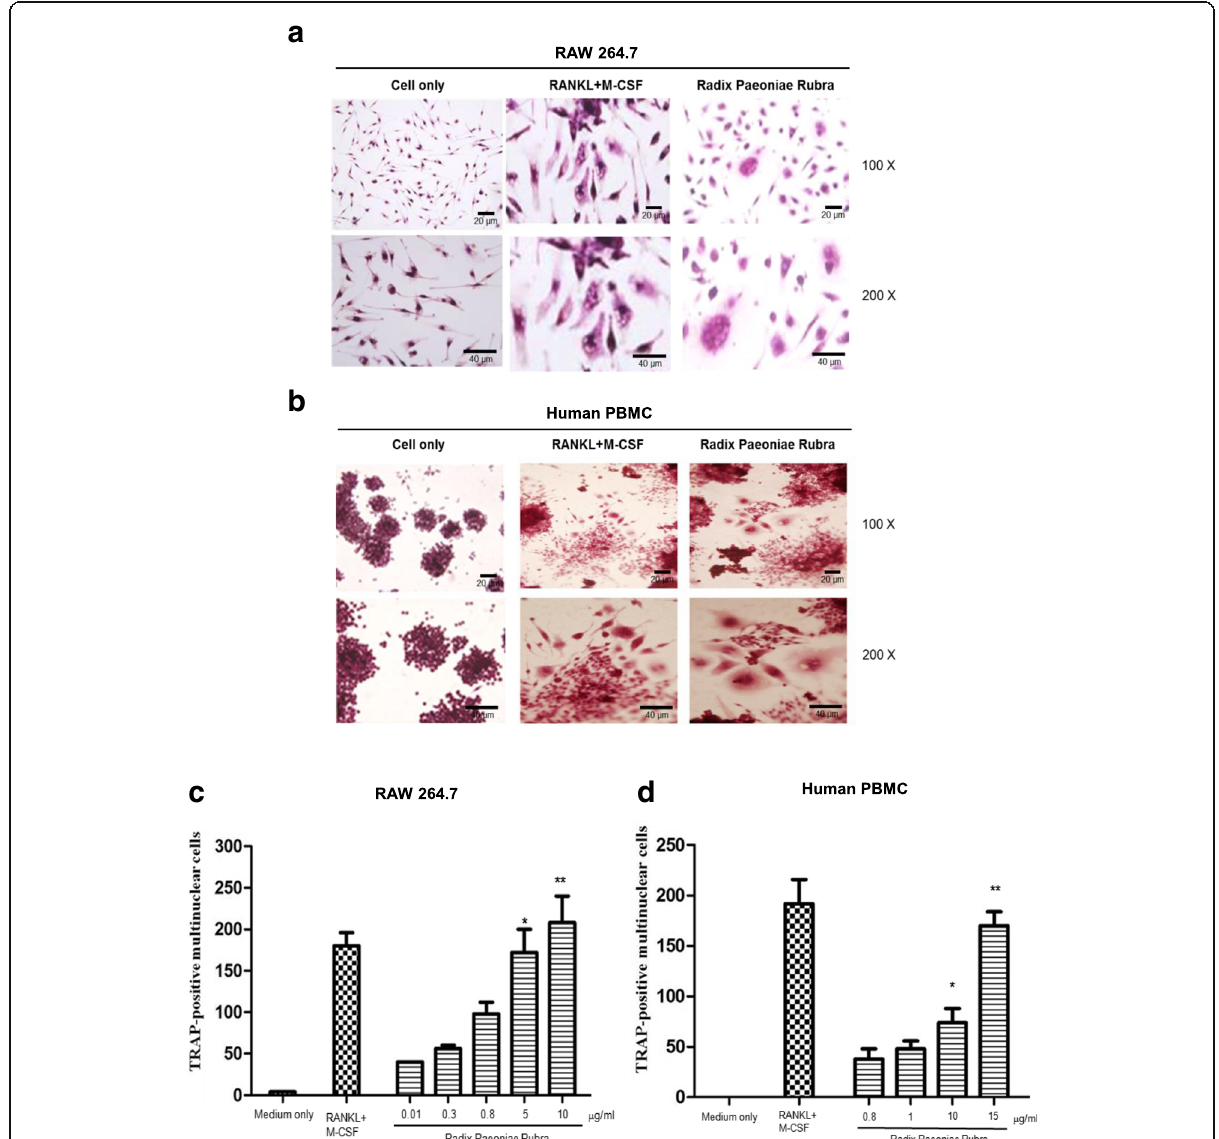
Fig. 1 RPR-induced osteoclast-like multi-nucleated cells from RAW264.7 macrophages and human monocytes. a RAW264.7 cells and ( b ) human PBMCs were cultured with RANKL+M-CSF or RPR, and then TRAP-stained. c RAW264.7 cells and ( d ) human PBMCs were cultured with RANKL+M-CSF or increasing concentrations of RPR, and then TRAP-stained. Data represent the mean ± SD of 3 – 6 individual experiments. * p < 0.01; ** p < 0.001, compared with the